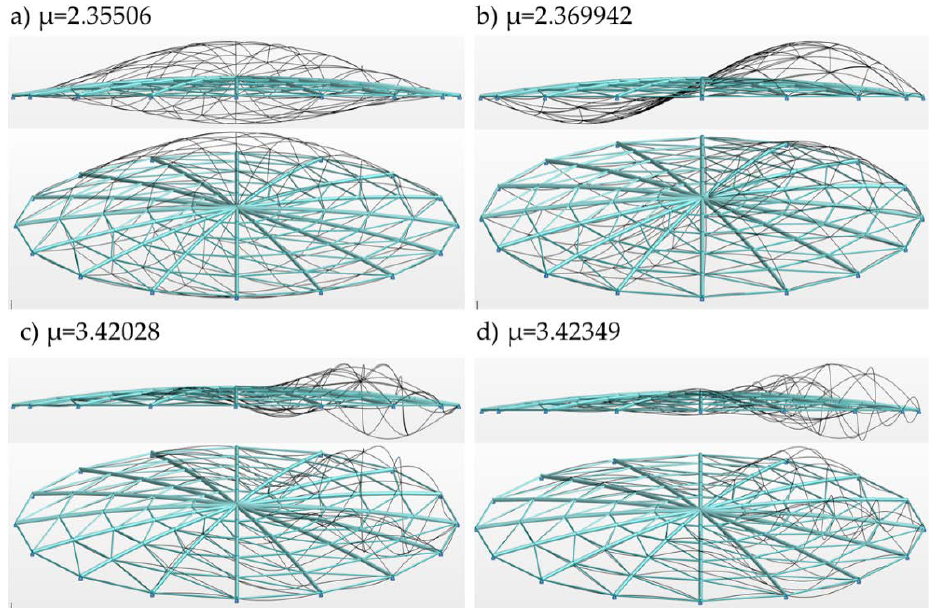
Figure 20. Buckling modes of the structure included wind suction: ( a ) 1st, ( b ) 2nd, ( c ) 3rd, ( d ) 4th.